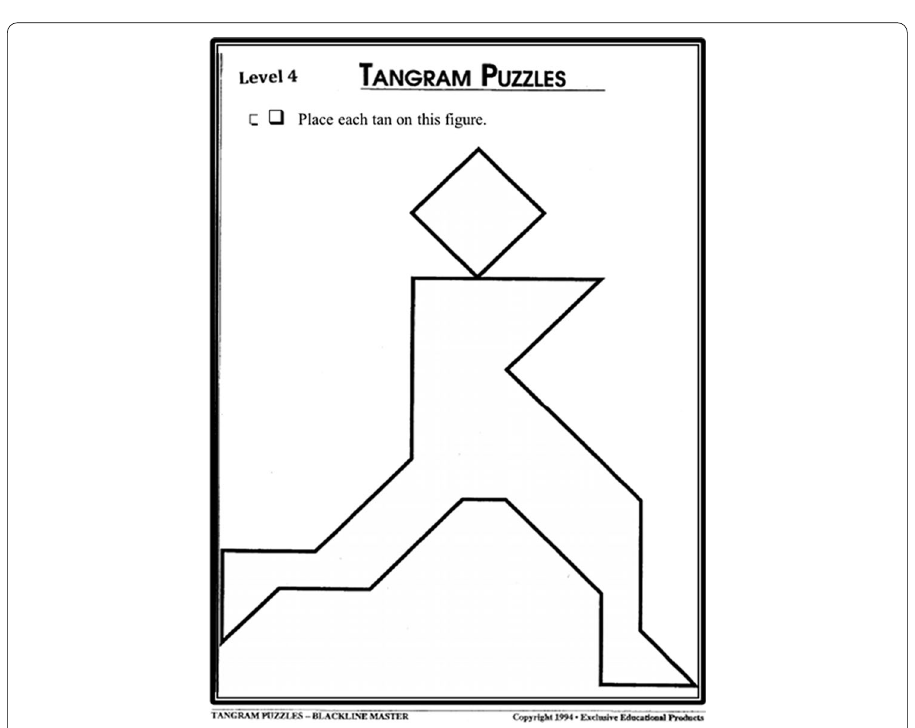
Fig. 7 Challenge Level 4 Sheets for Stage 5 taken from Tangram Blackline Masters